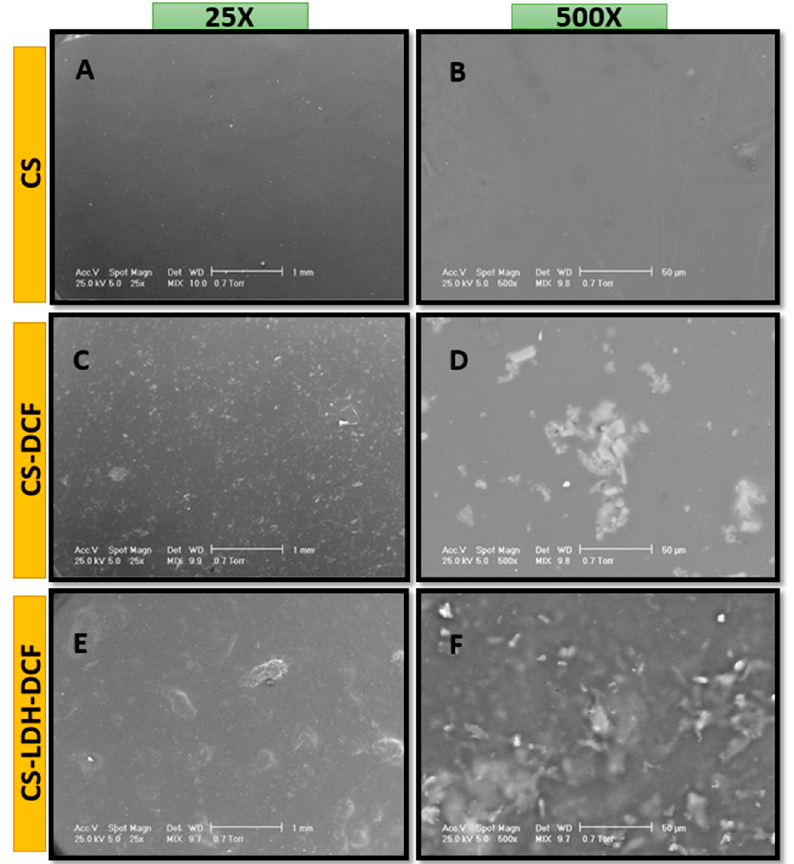
Figure 2. SEM images of neat chitosan (CS, ( A )—25 × , ( B )—500 × ), chitosan loaded with diclofenac (CS-DCF, ( C )—25 × , ( D )—500 × ), and chitosan–LDH loaded with diclofenac (CS-LDH-DCF, ( E )—25 × , ( F )—500 × ).